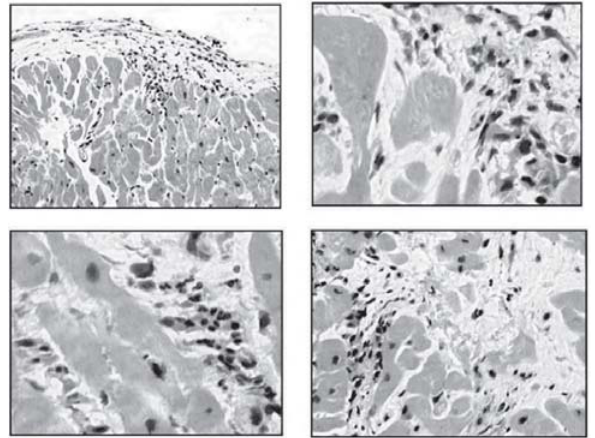
Fig. 3 - A light to moderate interstitial mononuclear infiltrate and interfibrilar edema (HE), different magnifications